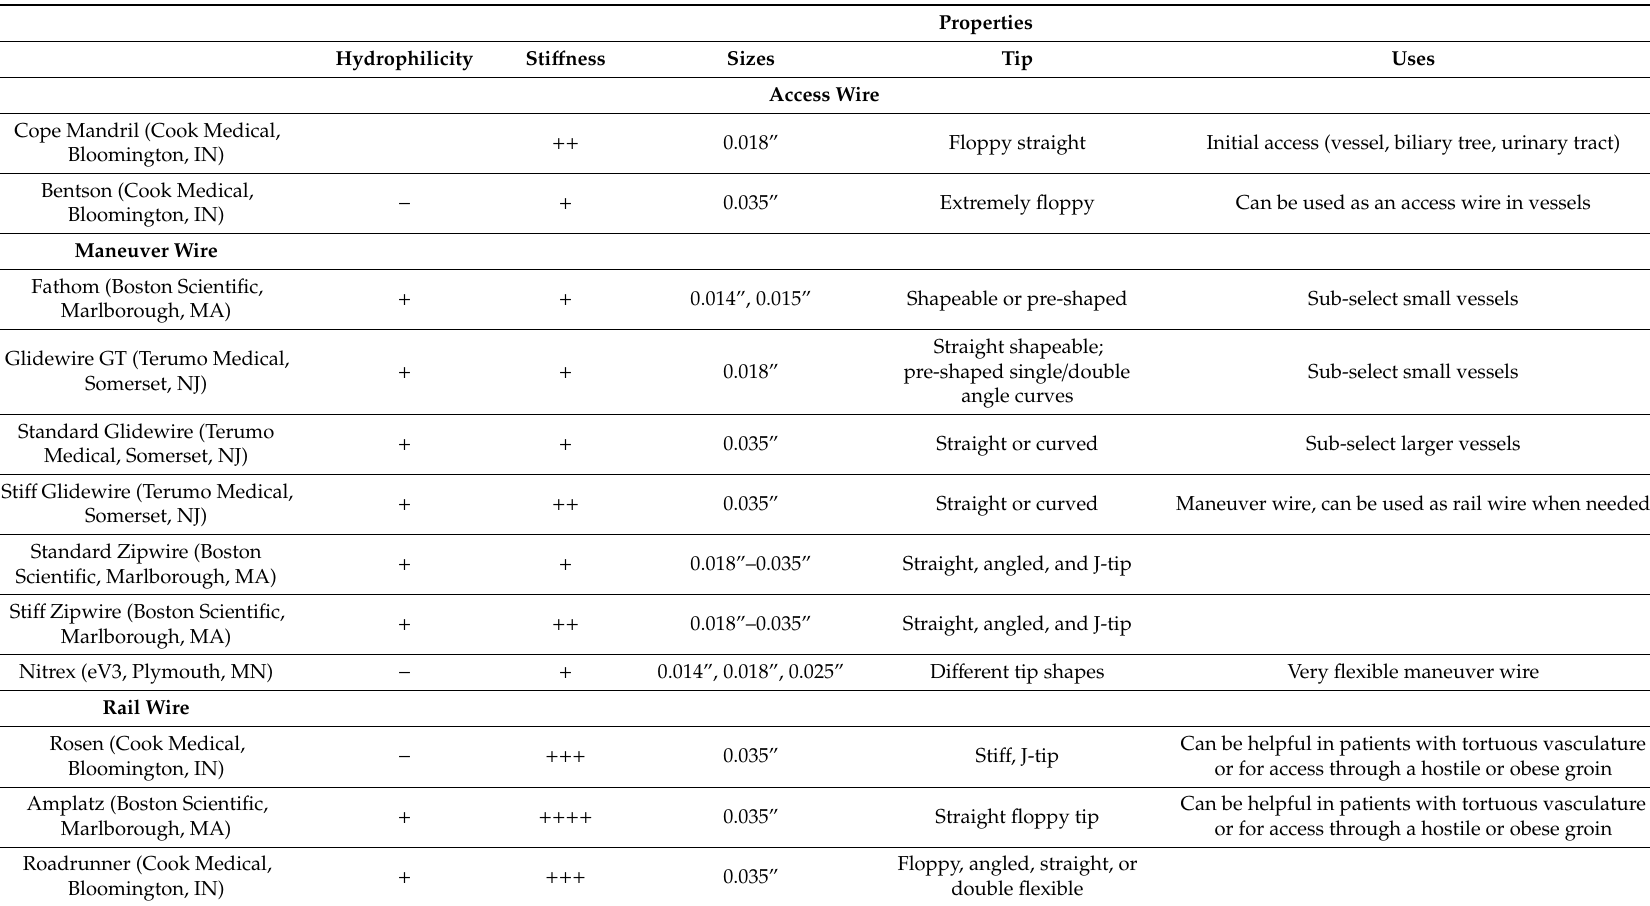
Table 1. Categories of wires with examples of available wires, properties, and